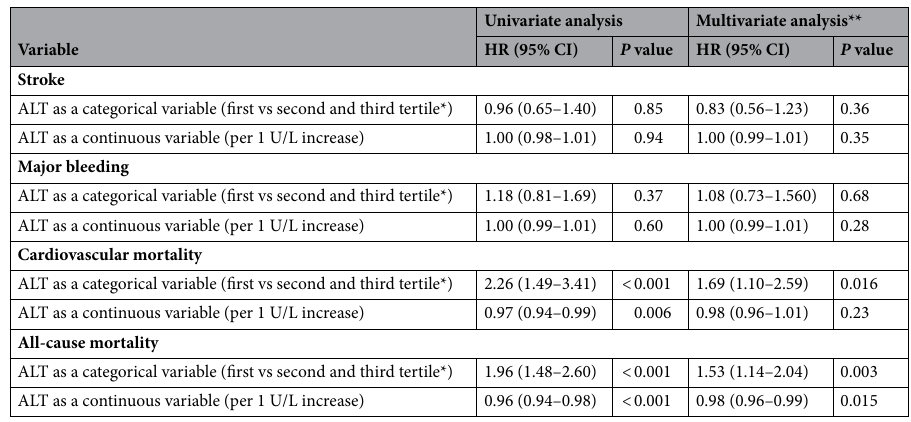
Table 2. Adverse clinical outcomes and results of the Cox proportional regression model according to tertile of baseline alanine aminotransferase level. *First tertile, baseline ALT ≤ 15 U/L, n = 1098; second tertile, 15 < ALT < 23 U/L, n = 1055; and third tertile, ALT ≥ 23 U/L, n = 1003. **Adjusted for age (≥ 75 years), sex, lower body weight (< 50 kg), AF type (persistent or long-standing persistent AF vs paroxysmal AF), hypertension,